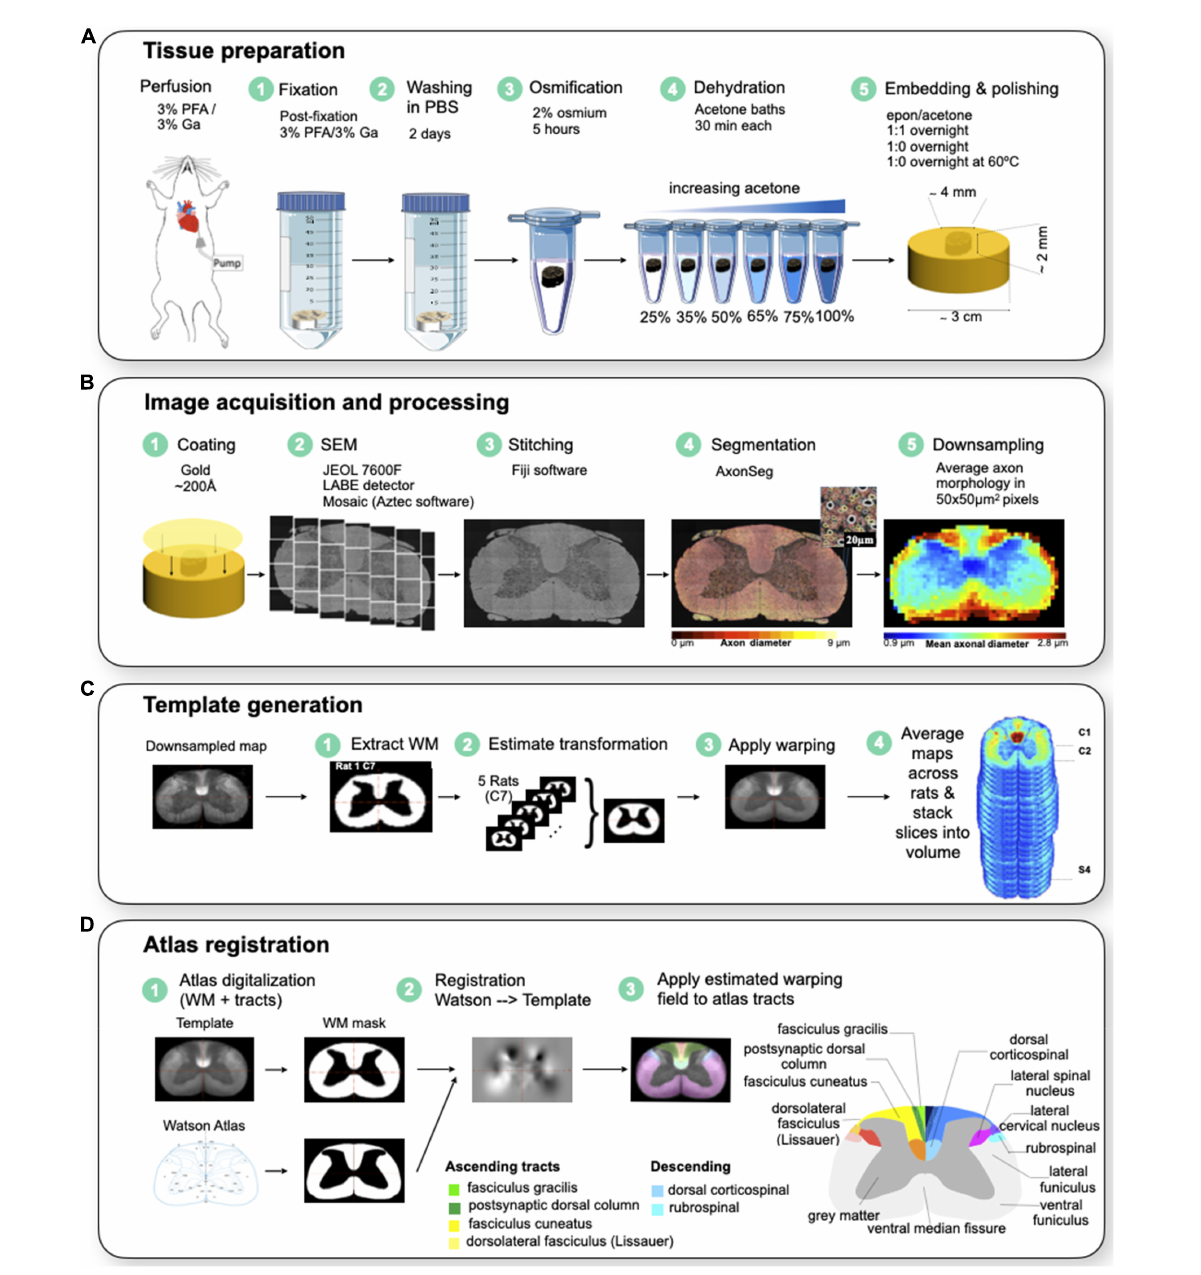
FIGURE1 (A) Animal/tissue preparation. The rat is first perfused and fixed to extract the spinal cord. The spinal cord is fixed in a 3% PFA and 3% GA solution for 2 days and washed in PBS for a subsequent 2 days before being stained with 2% Osmium tetroxide for 5 h. The cords are dehydrated in varying acetone baths before being embedded in a resin at 60 celsius overnight. The samples are polished to a 0.05 um surface finish. (B) Image acquisition and processing. The samples are imaged using a scanning electron microscope at 200X magnification for a 130 nm resolution. The images are stitched together using Fiji with an in-house MATLAB script to obtain a high resolution image of the spinal cord. (C) Template generation. A binary WM mask was created from downsampled maps for each sample, and put in a common space. The mask was then centered and aligned in the same direction. Affine and BsplineSyn transformations were used to register samples. The template was generated at each level, and was then concatenated into a single 4D NIfTI data structure. (D) Atlas registration. The Watson et al. spinal cord white matter atlas was symmetrized. A binary WM mask was made for the Watson et al. atlas and the template. The atlas registration to template was estimated based on the masks of white and gray matter of the atlas (source) and generated template (destination). WM tracts were registered by applying the estimated warping fields to the atlas tracts. WM tracts were then put in the same space as the template using the transformation. Modified with permission from Saliani et al.